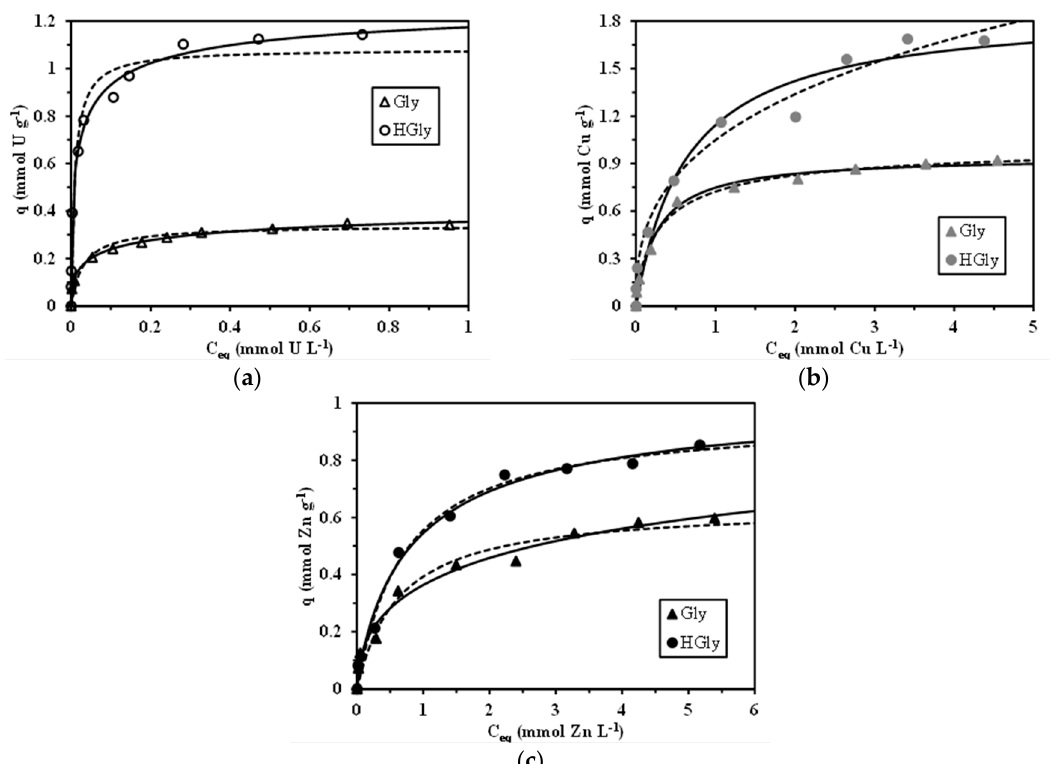
Figure 3. Sorption isotherms for the recovery of U(VI) ( a ); Cu(II) ( b ); and Zn(II) ( c ) using Gly and HGly sorbents at pH 0 : 5 (dashed lines: modeling with the Langmuir equation; solid lines: modeling with the Sips equation) (pH: 5; T: 20 °C, v: 150 rpm; time: 48 h; SD: 300 mg · L − 1 for U(VI), 350 mg · L − 1 for Cu(II), and 500 mg · L − 1 for Zn(II)).